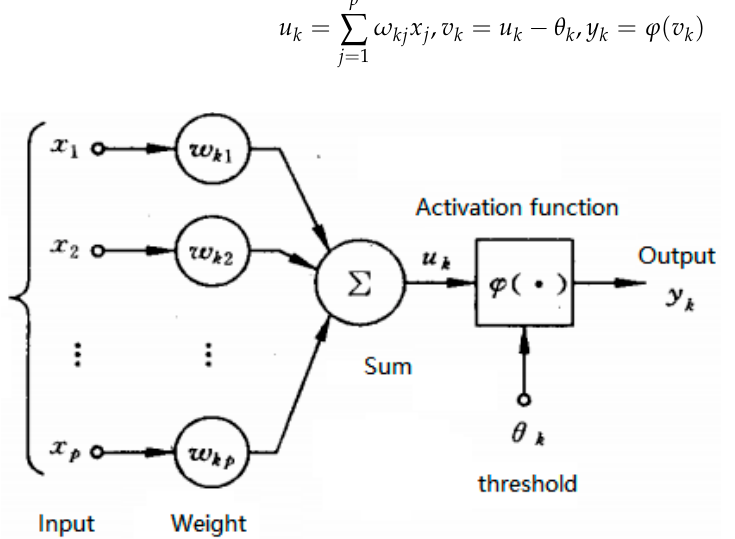
Figure 2. Basic neuron model.